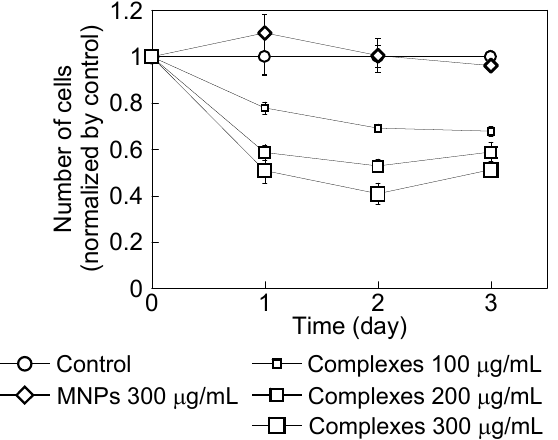
Figure 3. HeLa cell growth in the presence of polyethylenimine (PEI)-coated magnetic nanoparticles (MNPs) at 300 μ g/mL and with MNP/antibody complexes added at 100, 200 and 300 μ g/mL. The control did not include these treatments. Cell numbers were normalized by the number of control cells. Cell numbers decreased with increasing complex doses.